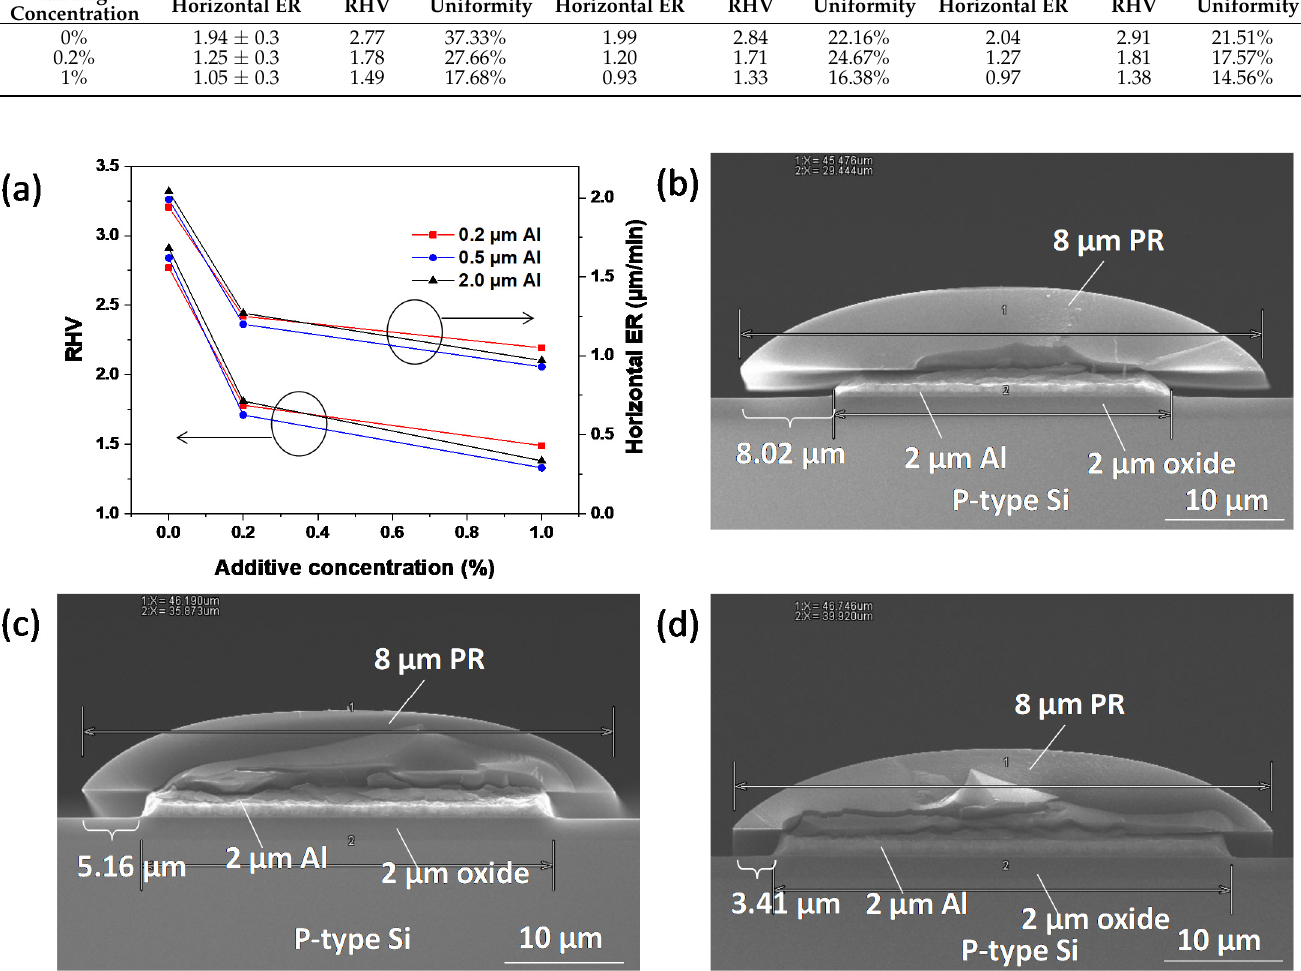
Figure 4. ( a ) Extracted values of RHV and horizontal ER as a function of additive mixing concentration and SEM images of 2 μ m Al in etchants of concentration ( b ) No additive, ( c ) 0.2%, ( d ) 1%, for 4 min. Figure 4b,d demonstrated the microstructure and morphology of 2.0 µ m thick Al